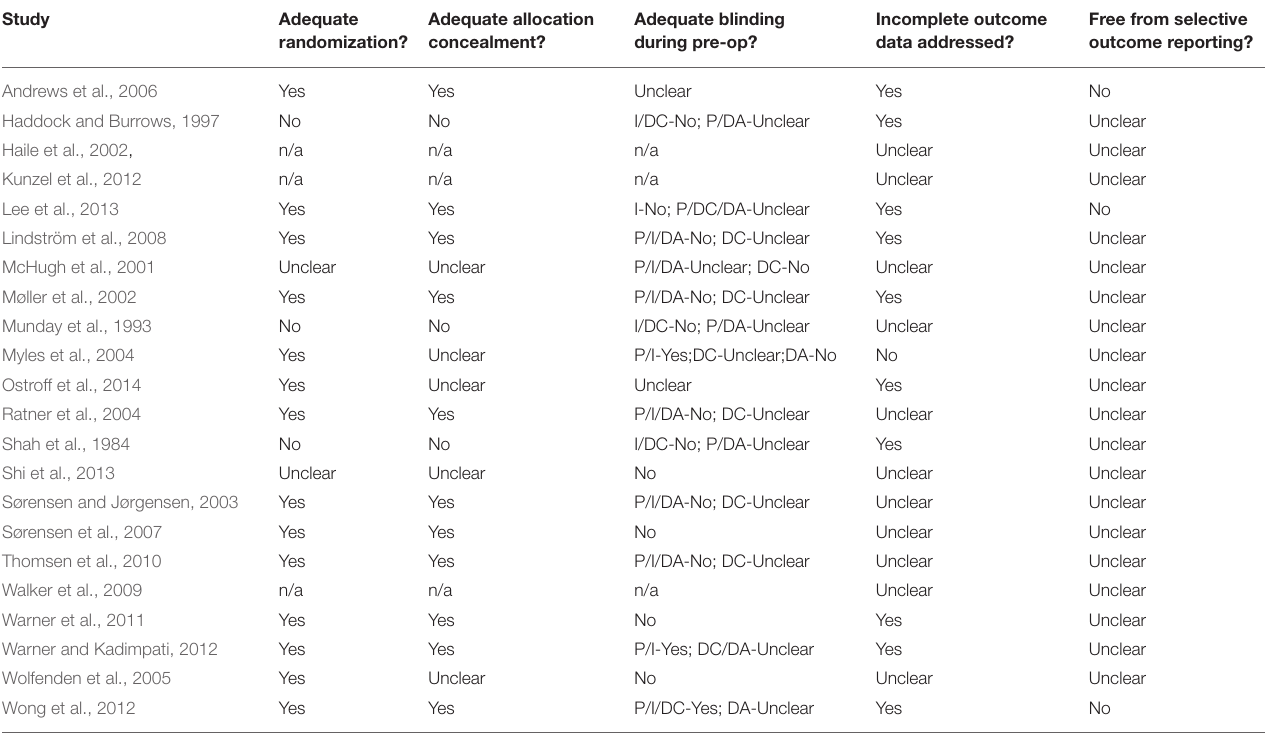
TABLE 5 | Risk of Bias.